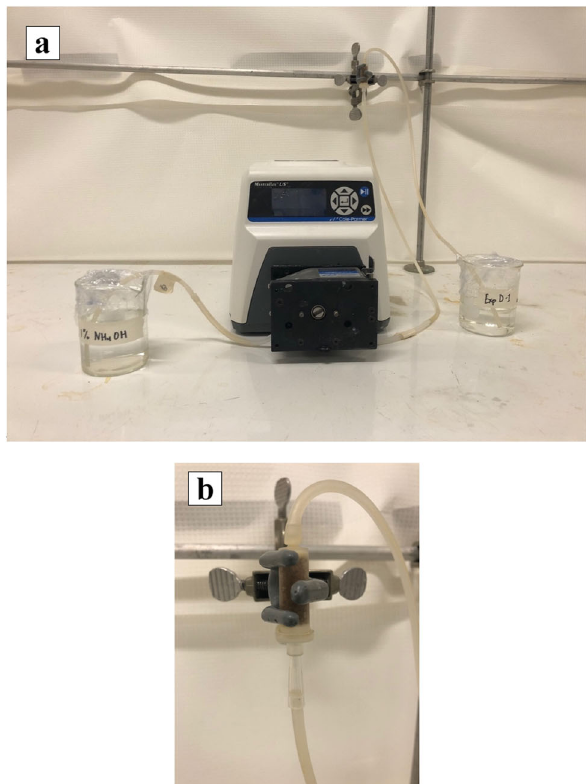
Fig. 4 Graphical representation of the microcolumn. a Micro- column set-up showing the in fl uent and ef fl uent collection receptacles and the peristaltic pump used; b a close-up of the